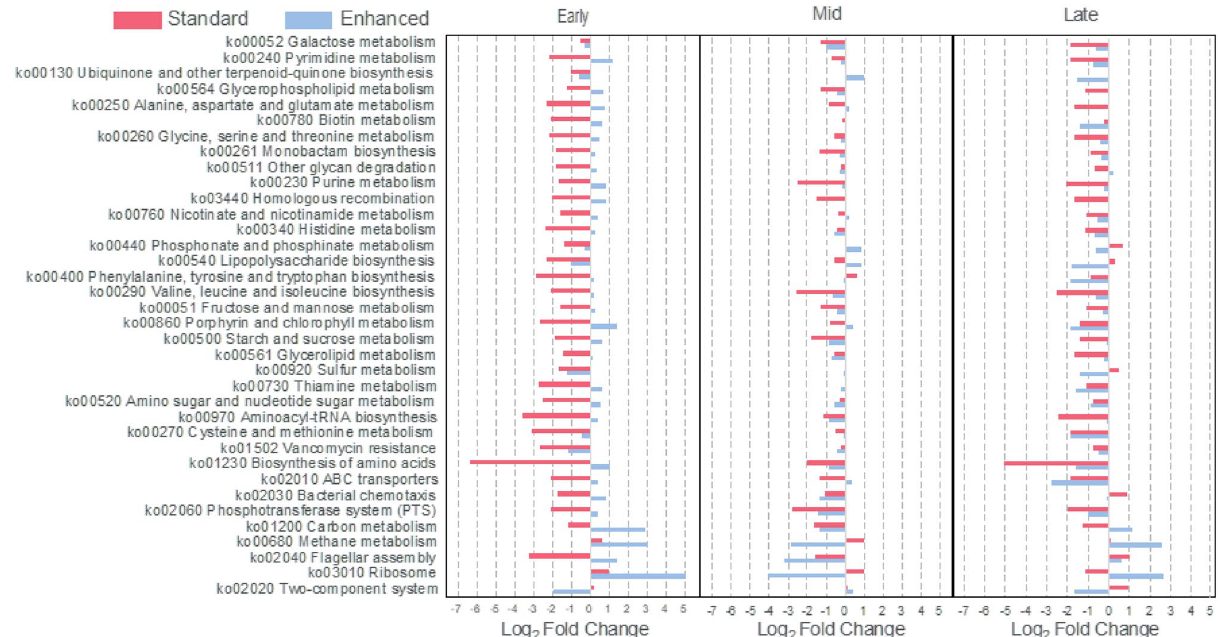
Figure 8. Metatranscriptomic changes in-mission compared to pre-mission for a subset of enhanced diet subjects (average fold changes in blue) and standard diet subjects (average fold changes in red). Several pathways were downregulated for standard diet subjects early in the mission but began to normalize by mid-mission. SI Appendix , Fig. S5 shows changes by individual for the ‘Early’ timepoint in the